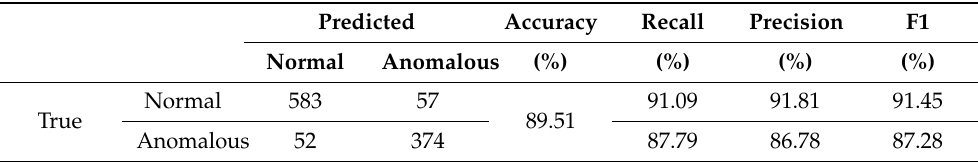
Table 5. Confusion matrix and related performance metrics for the test set in the first experimentation.